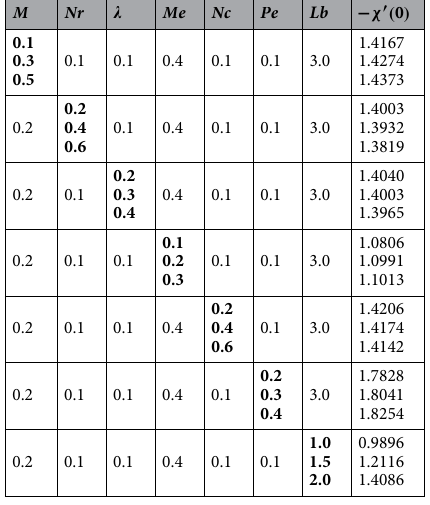
χ ′ ( 0 ) for specific magnitudes of M , −